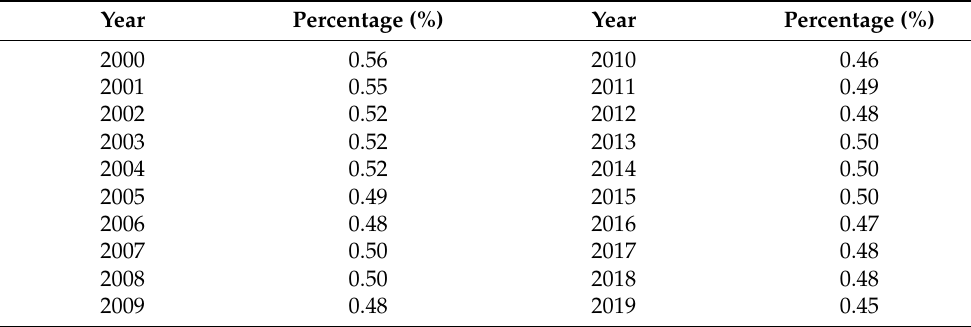
Table 2. The percentage of the MODIS IST pixels that had been